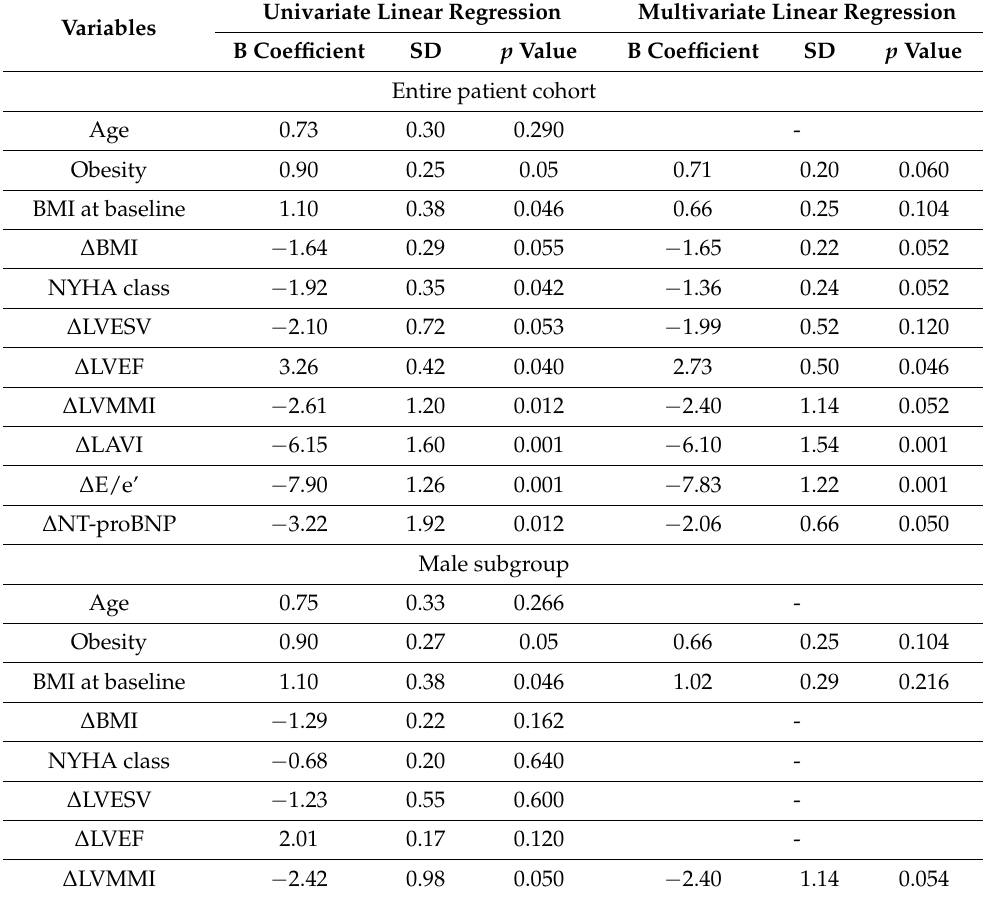
Table 3. Univariate and multivariate linear regression analyses of the association of adropin levels with age, abdominal obesity, BMI, NYHA class, and relative changes in hemodynamics and NT-proBNP.